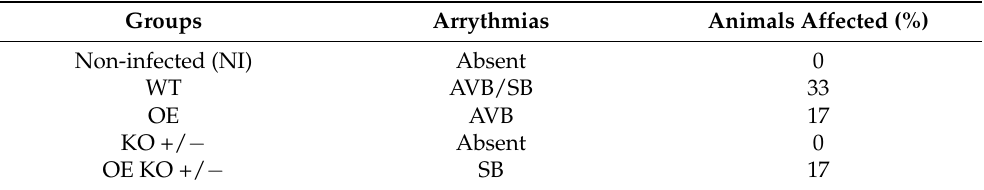
Table 1. Electrocardiographic alterations frequency in animals non-infected (NI) or infected with (wild type) WT, (overexpressed) OE, (hemi-knockout) KO +/ − , and (overexpressed hemi-knockout) OE KO +/ − .